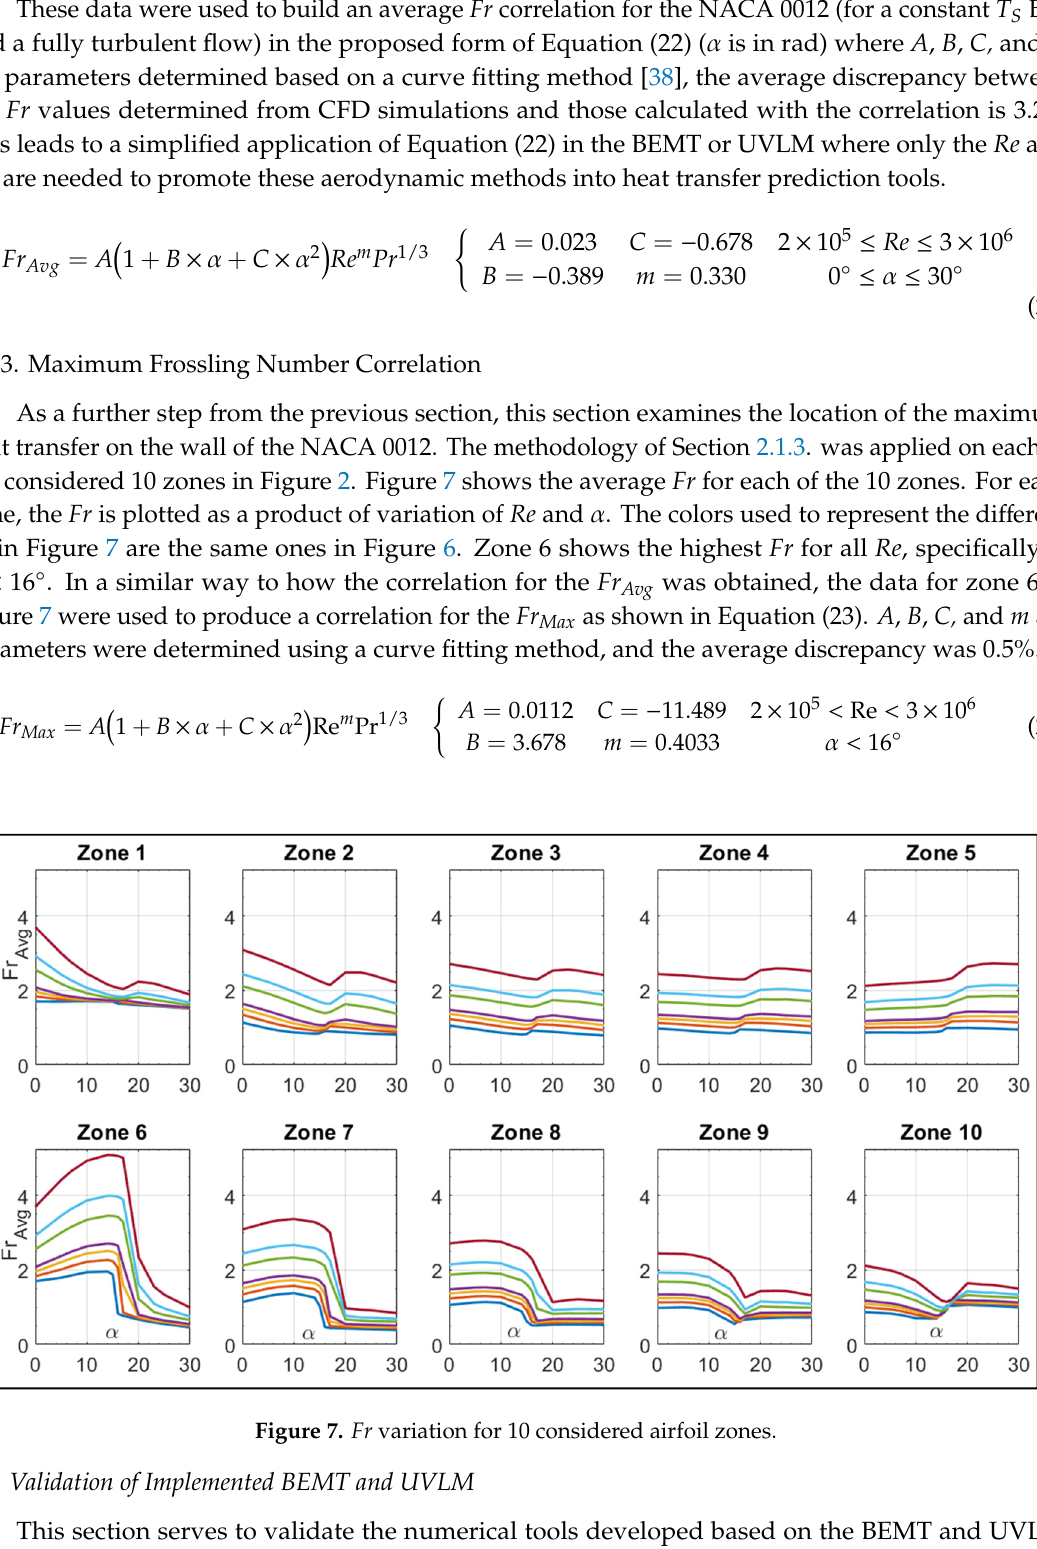
Figure 6. Average Fr variation with respect to Re and α .